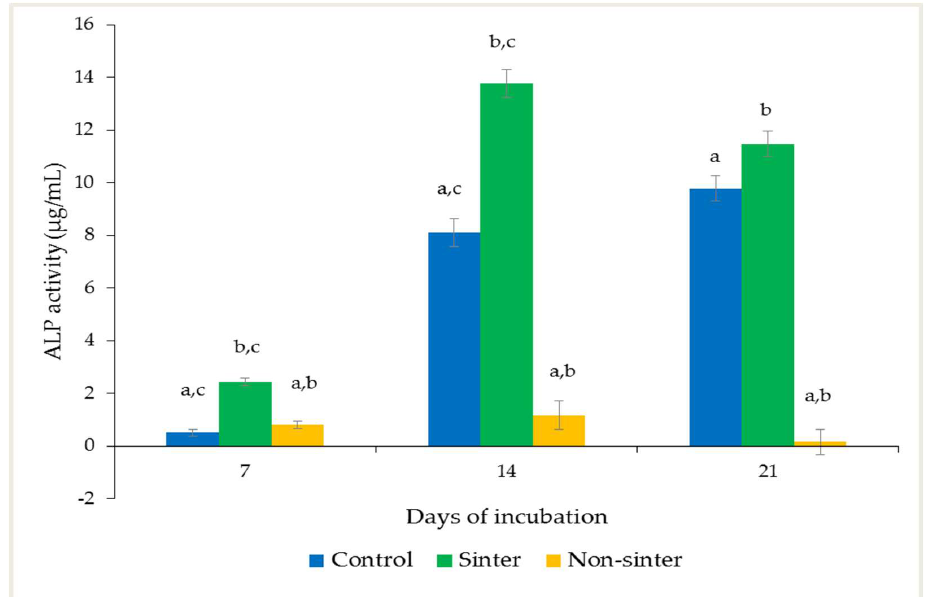
Figure 5. Alkaline phosphatase (ALP) activity of MC3T3-E1 preosteoblast cells seeded on sinter and nonsinter hydroxyapatite scaffolds. Cells without a scaffold were considered to be the control group. Same letter of a, b, c in each incubation day denotes significant differences within group ( p <